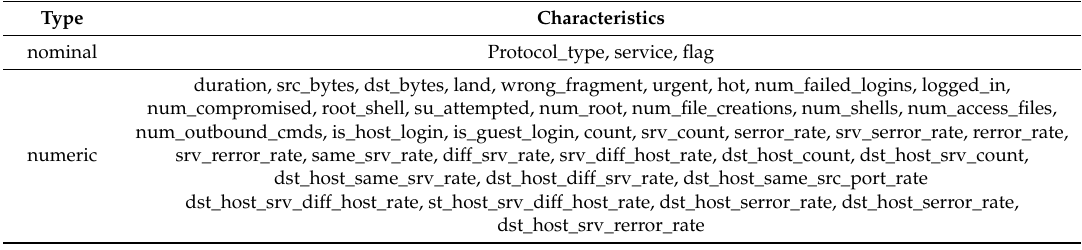
Table A1. Attribute